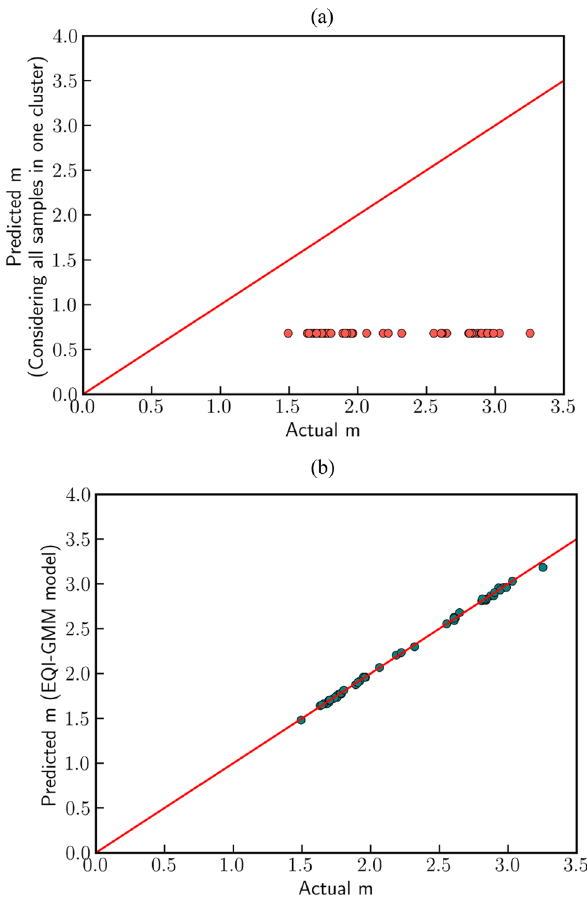
Fig. 10 Cross plot of predicted cementation factor by a Archie’s law and b the proposed EQI-based clustering model versus actual values for testing data from sandstone